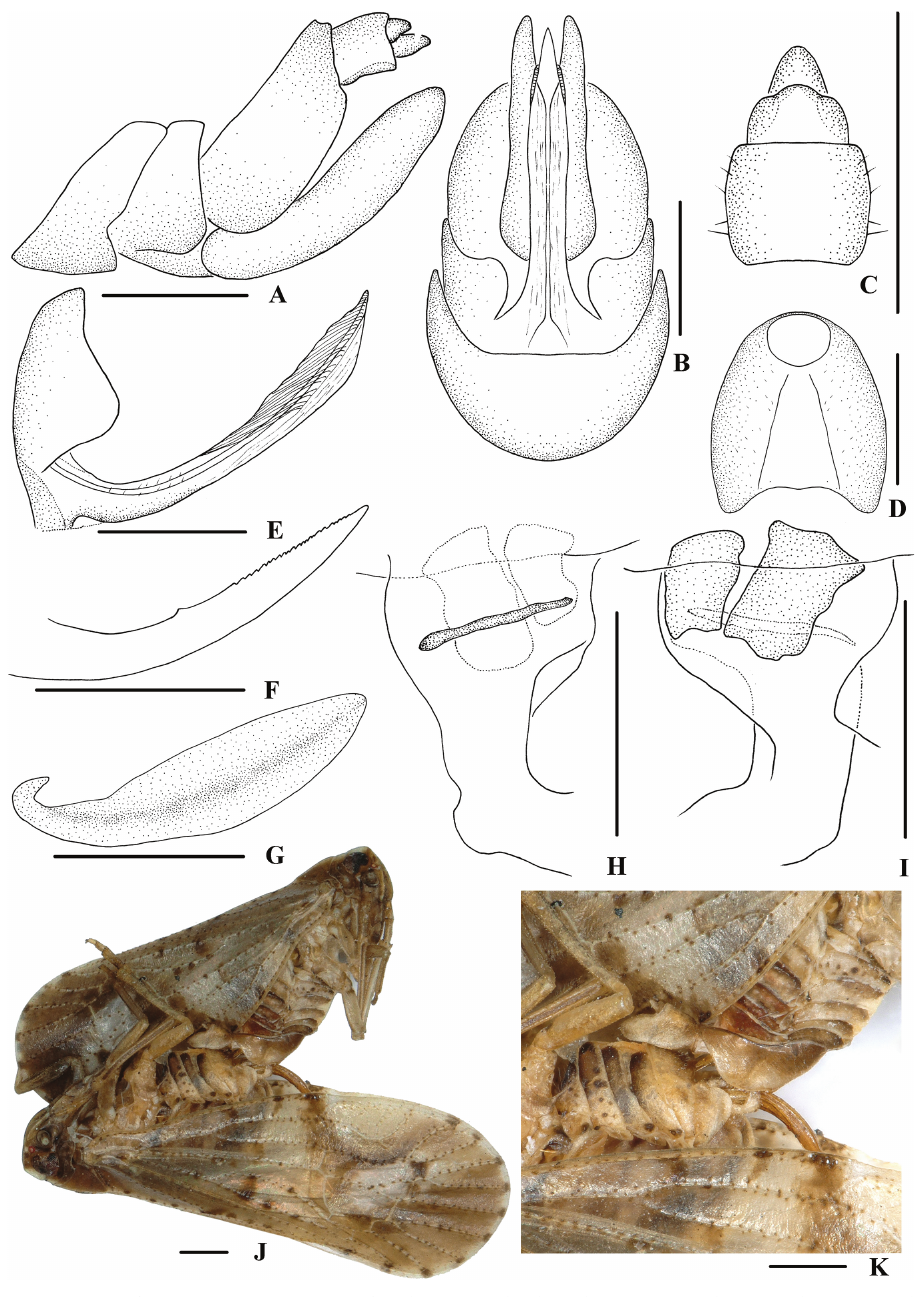
Figure 3. Kirbyana aspina sp. nov., A–I female A genitalia, lateral view B genitalia, ventral view C anal segment, dorsal view D tergite IX, caudal view E gonapophysis VIII and gonocoxa VIII, ventral view F gonapophysis IX, lateral view G gonoplac, lateral view H posterior vagina, dorsal view I posterior vagina, ventral view J, K mating. Scale bars: 0.5